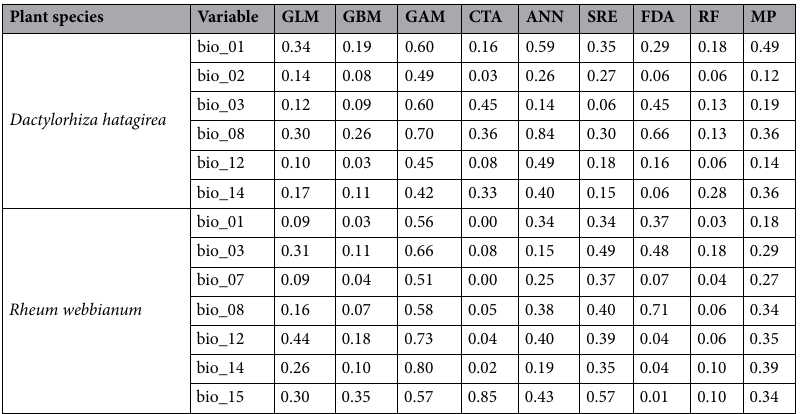
Table 4. Overall and algorithm wise importance scores of the selected bioclimatic variables for Dactylorhiza hatagirea and Rheum webbianum.